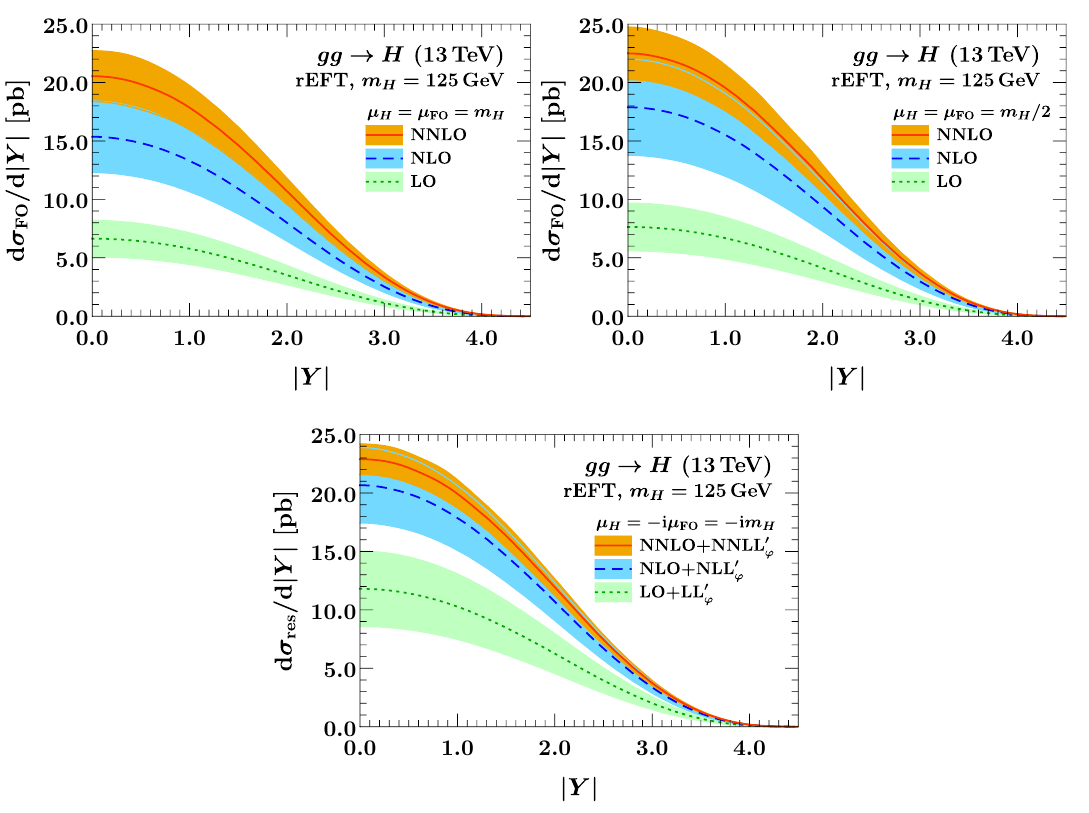
Figure 6 . The rapidity distribution for gg ! H at E cm = 13 TeV and m H = 125 GeV in the rEFT limit. The (cid:12)xed-order results are shown in the top row at (cid:22) FO = m H (left) and (cid:22) FO = m H = 2 (right). The resummed result is shown on the bottom. The uncertainty bands indicate (cid:1) (cid:22) and (cid:1) (cid:22) (cid:8) (cid:1) ’ ,